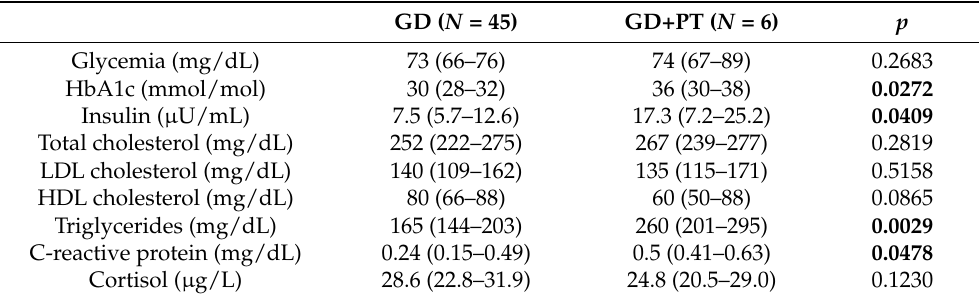
Table 3. Metabolic and inflammatory parameters at T0 of subjects with GD who required therapy to normalize blood glucose levels (GD+PT) and subjects who did not require pharmacological intervention